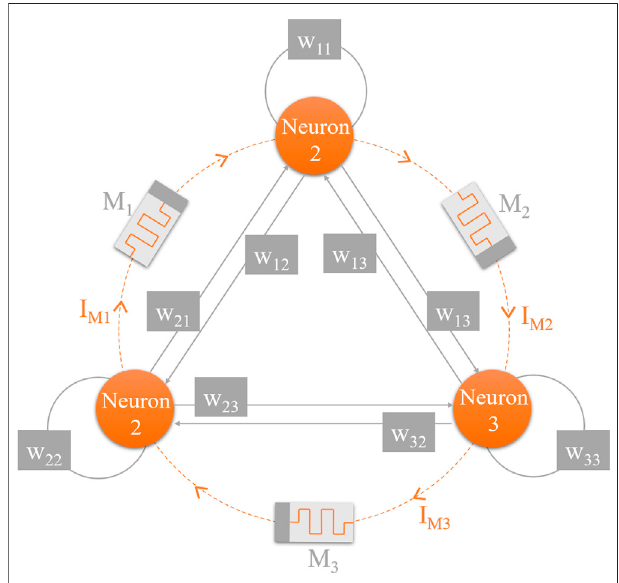
FIGURE 2 | Schematic diagram of the connection topology of a trimemristor-coupled HNN